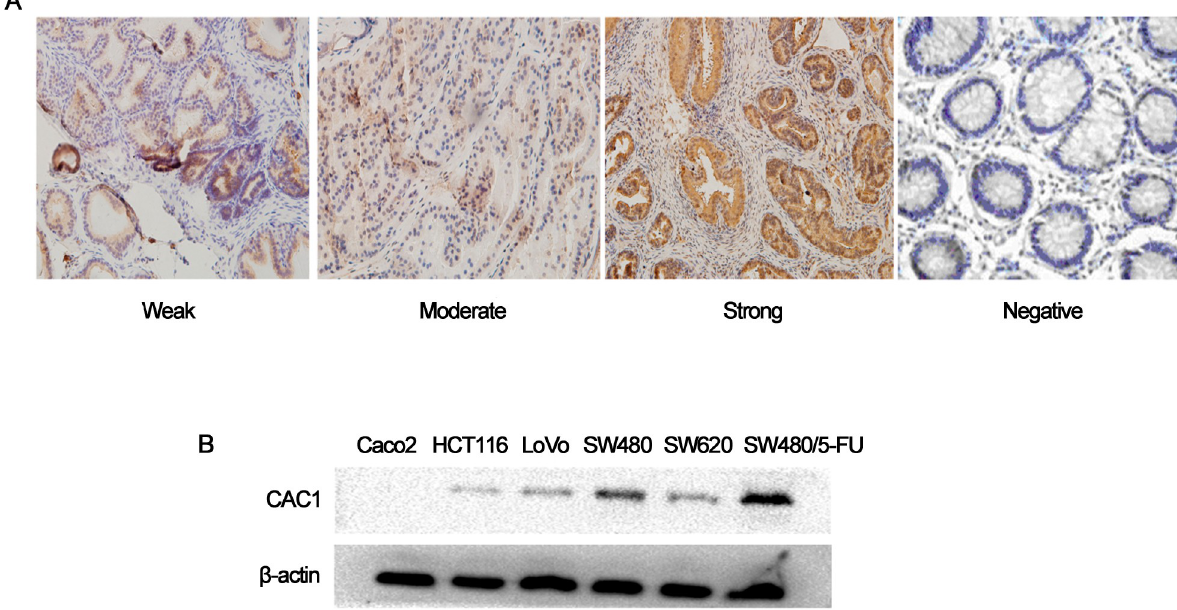
Fig 1. CAC1 protein expression in CRC tissues and cell lines. (A) The immunohistochemistry analysis of CRC tissues and its corresponding normal tissue samples are shown, and the tissue microarray sections were classified into four groups, according to staining intensity ( × 200). (B) The western blot analysis of CAC1 expression in CRC cell lines and drug resistance cell line SW480/5-FU is shown.